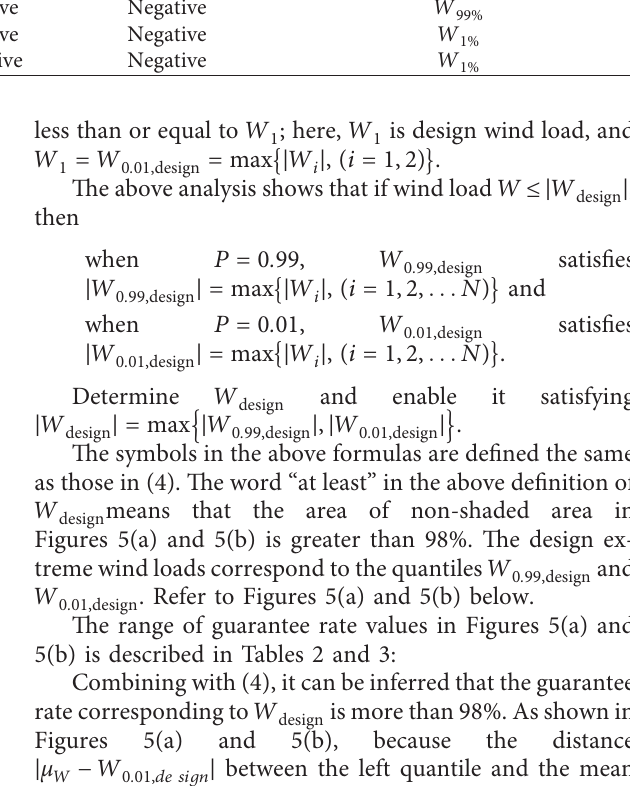
Figure 3: Diagram of relationship between quantile and guarantee rate. (a) Illustration of design extreme wind pressure controlled by W (b) Illustration of design extreme wind pressure controlled by W (d) Illustration of design extreme wind pressure controlled by W